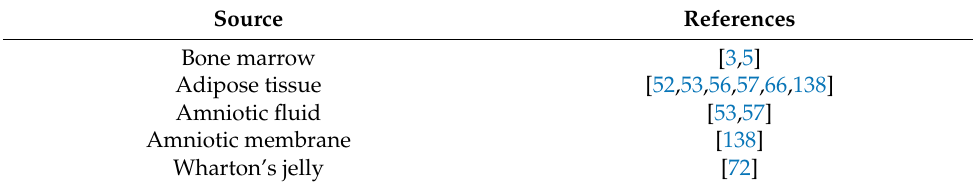
Figure 2. Schematic diagram of the somatic cell nuclear transfer (SCNT) technology (created in Biorender.com, accessed on 14 July 2022). Table 4. Bovine MSCs from different sources as nucleus donors for nuclear